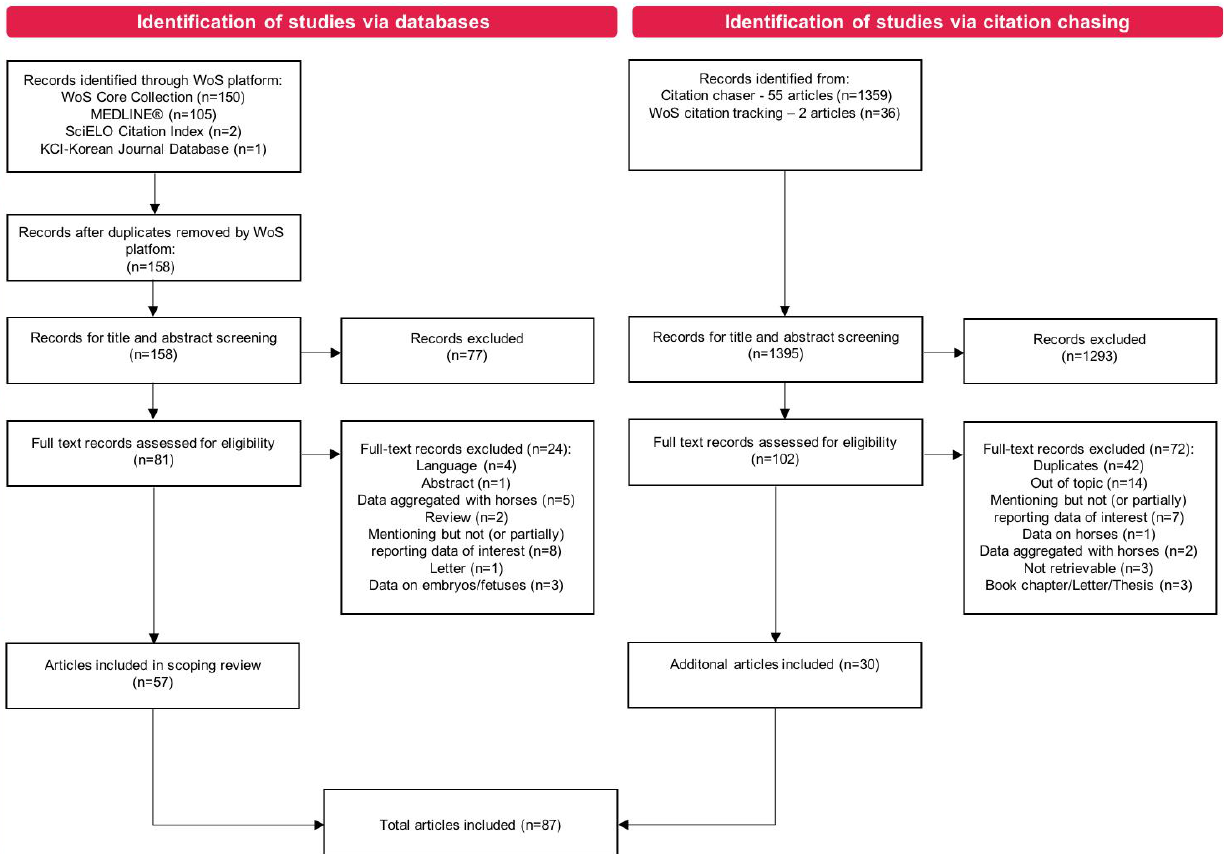
(Figure 3A: distribution of literature by region), with USA, Iran, and Egypt being the three countries where more studies were conducted (Figure 3B: distribution of literature by nation). Overall, 83% of articles (n = 72) were classified as original research articles, whereas the remaining (n = 15) were short communications or case